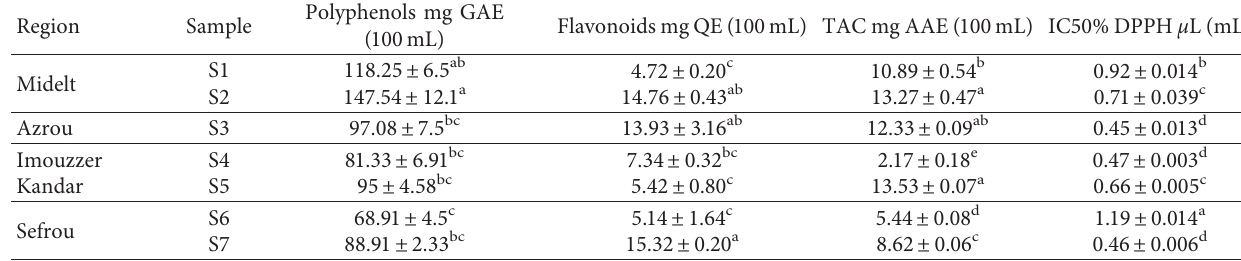
Table 3: Phytochemical content and antioxidant activities of vinegars.